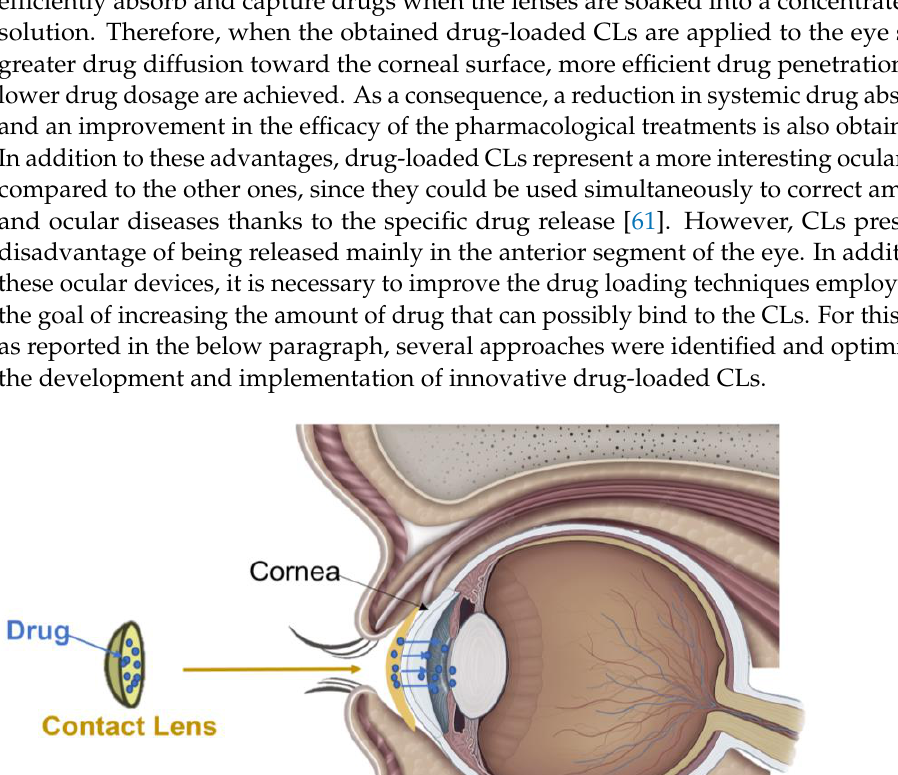
Table 2. Summary of the studies for drug-loaded CLs .